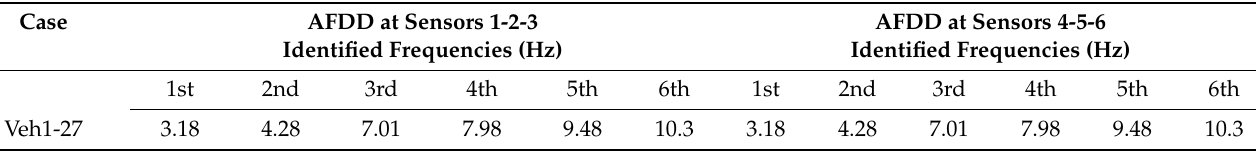
Table 17. Identified frequencies of numerical results with FDD method in the transverse direction (Offset Lane).